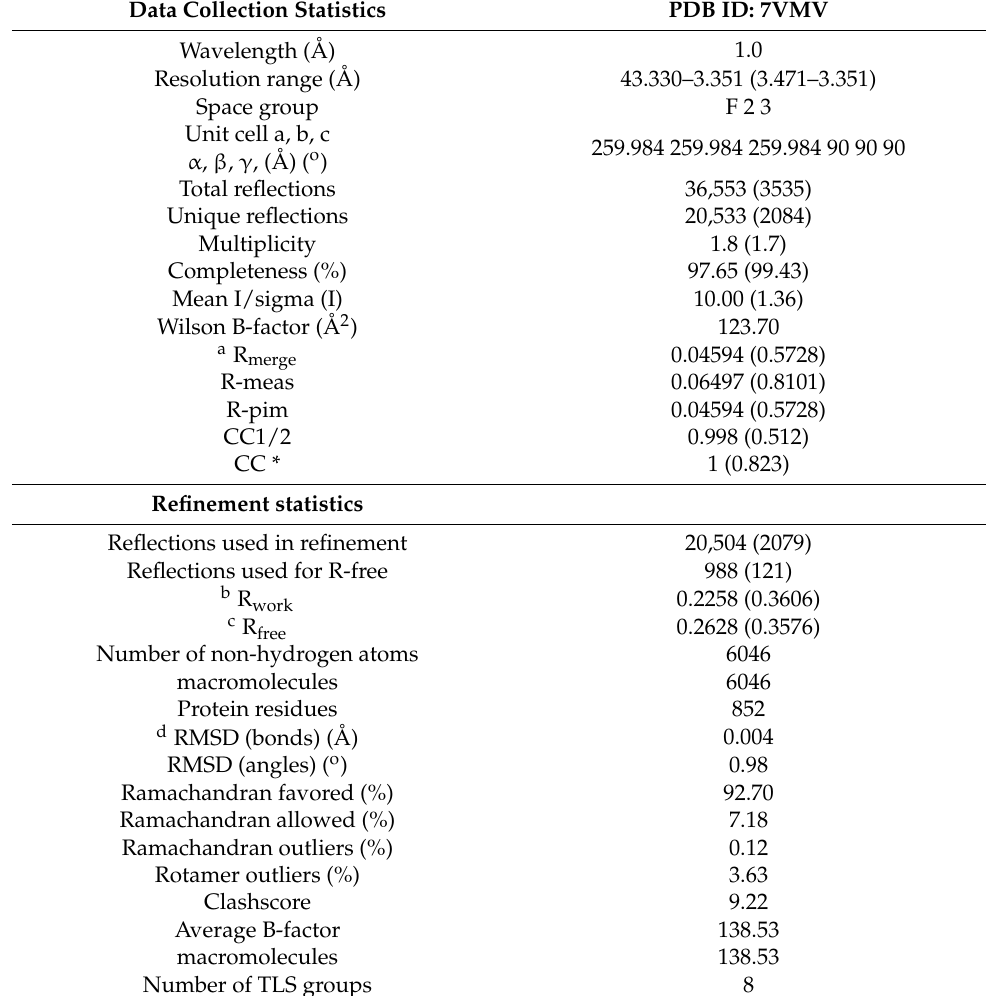
Table 1. Data collection and refinement